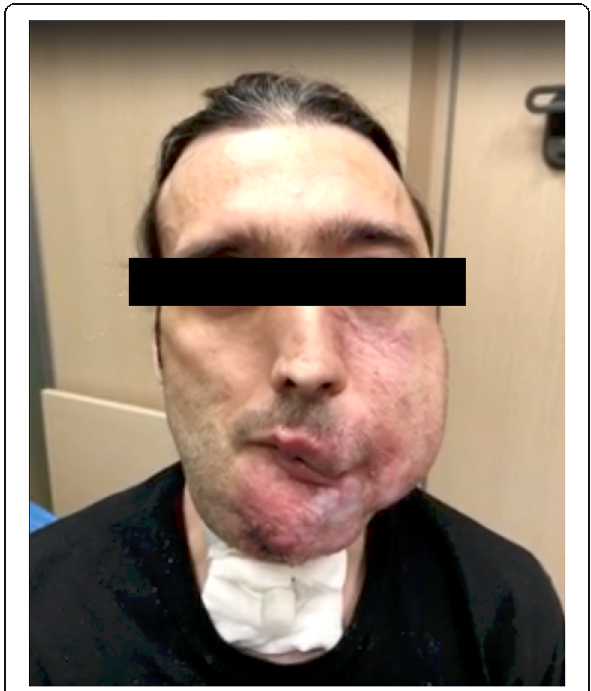
Fig. 1 External presentation. Large arteriovenous malformation involving patient ’ s left hemiface and tongue